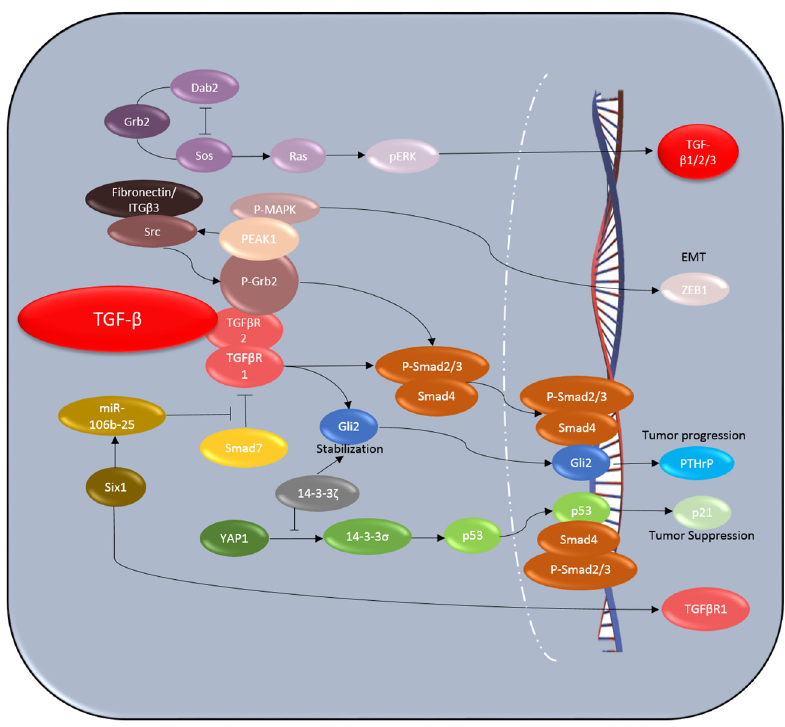
Figure1. Schematic diagram of the context ‐ dependent TGF ‐β signaling pathway. Figure 1. Schematic diagram of the context-dependent TGF- β signaling